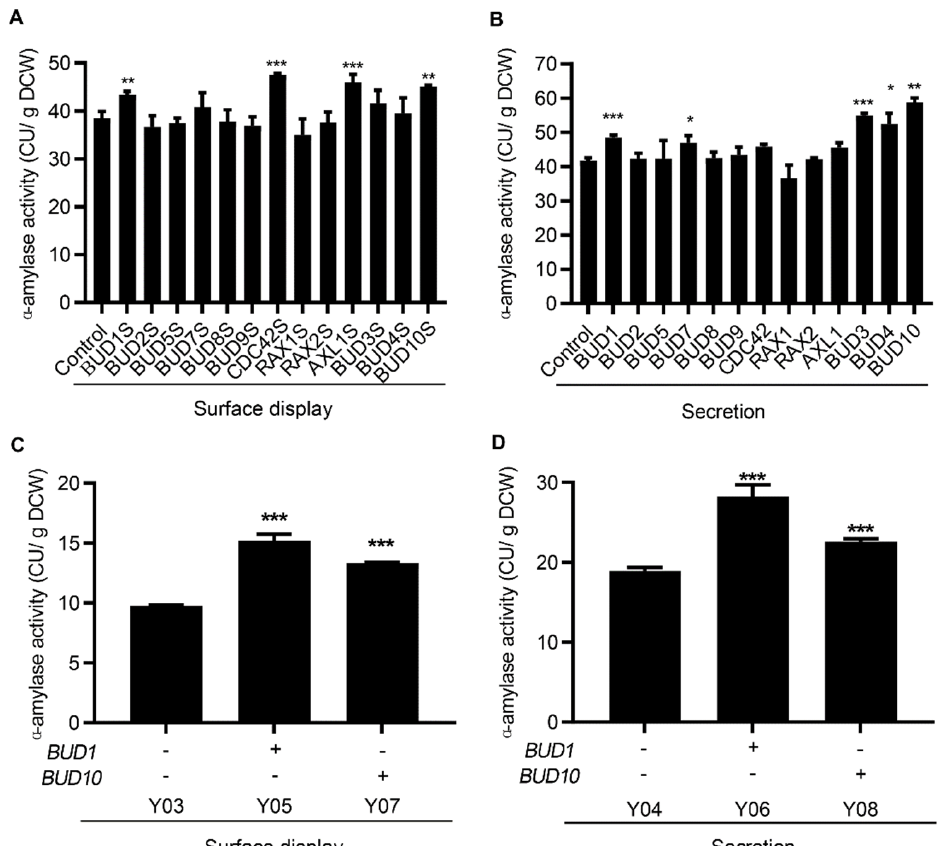
Figure 2. Engineering cell polarization enhanced α -amylase. The effect of engineering cell polarization on the activity of surface-displayed ( A ) and secreted ( B ) α -amylase. The effect of BUD1 and BUD10 expression on surface-displayed ( C ) and secreted ( D ) α -amylase. All strains involved in ( A , B ) were cultivated in the SC − AA medium without uracil at 30 °C for 24 h, and strains involved in ( C , D ) were cultivated in the YPD medium at 30 °C for 24 h. Data are mean ± SD from three independent experiments. The statistical significance of enzymatic assays was determined by a two − tailed homoscedastic (equal variance) t -test and one asterisk represents p < 0.05, two asterisks represent p < 0.01, and three asterisks represents p < 0.005.